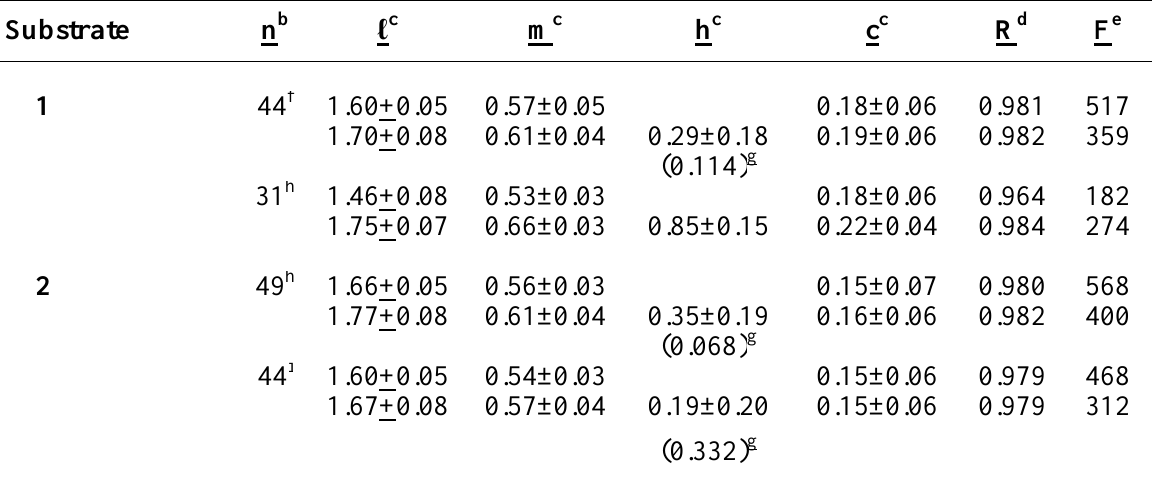
Table 2. Correlations a of the specific rates of solvolysis of p -methoxyphenyl chloroformate ( 1 ) and a comparison with the corresponding values for phenyl chloroformate ( 2 ) solvolyses.